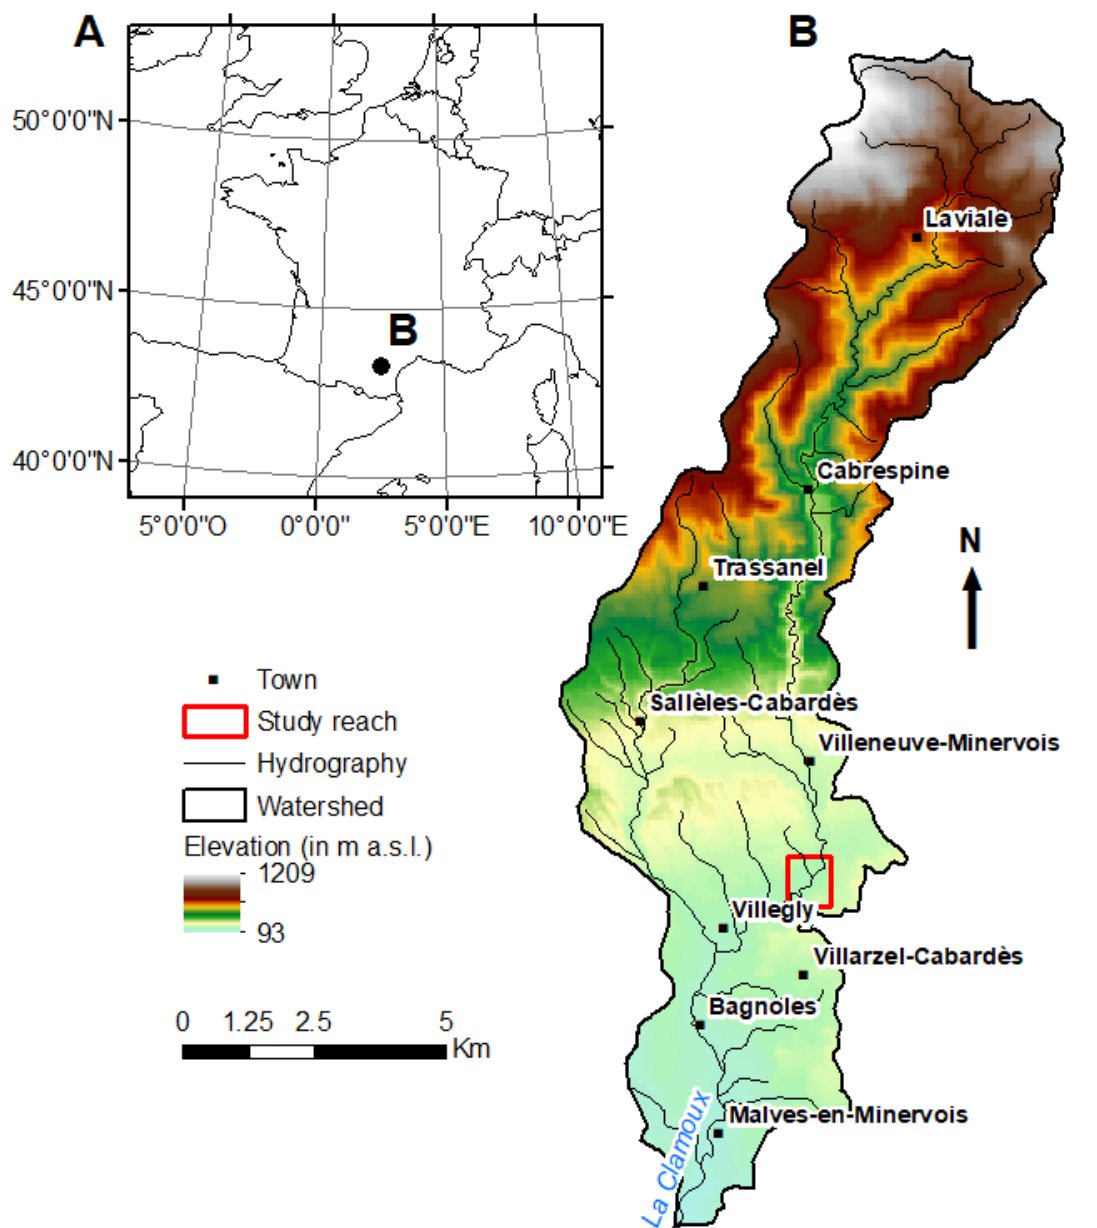
Figure 7. Location of the study area (Clamoux River, Aude watershed, Mediterranean France) ( A ). The Digital Elevation Model (DEM) ( B ) was deduced from the 2018 orthophotograph provided by the French National Geographic Institute (IGN).